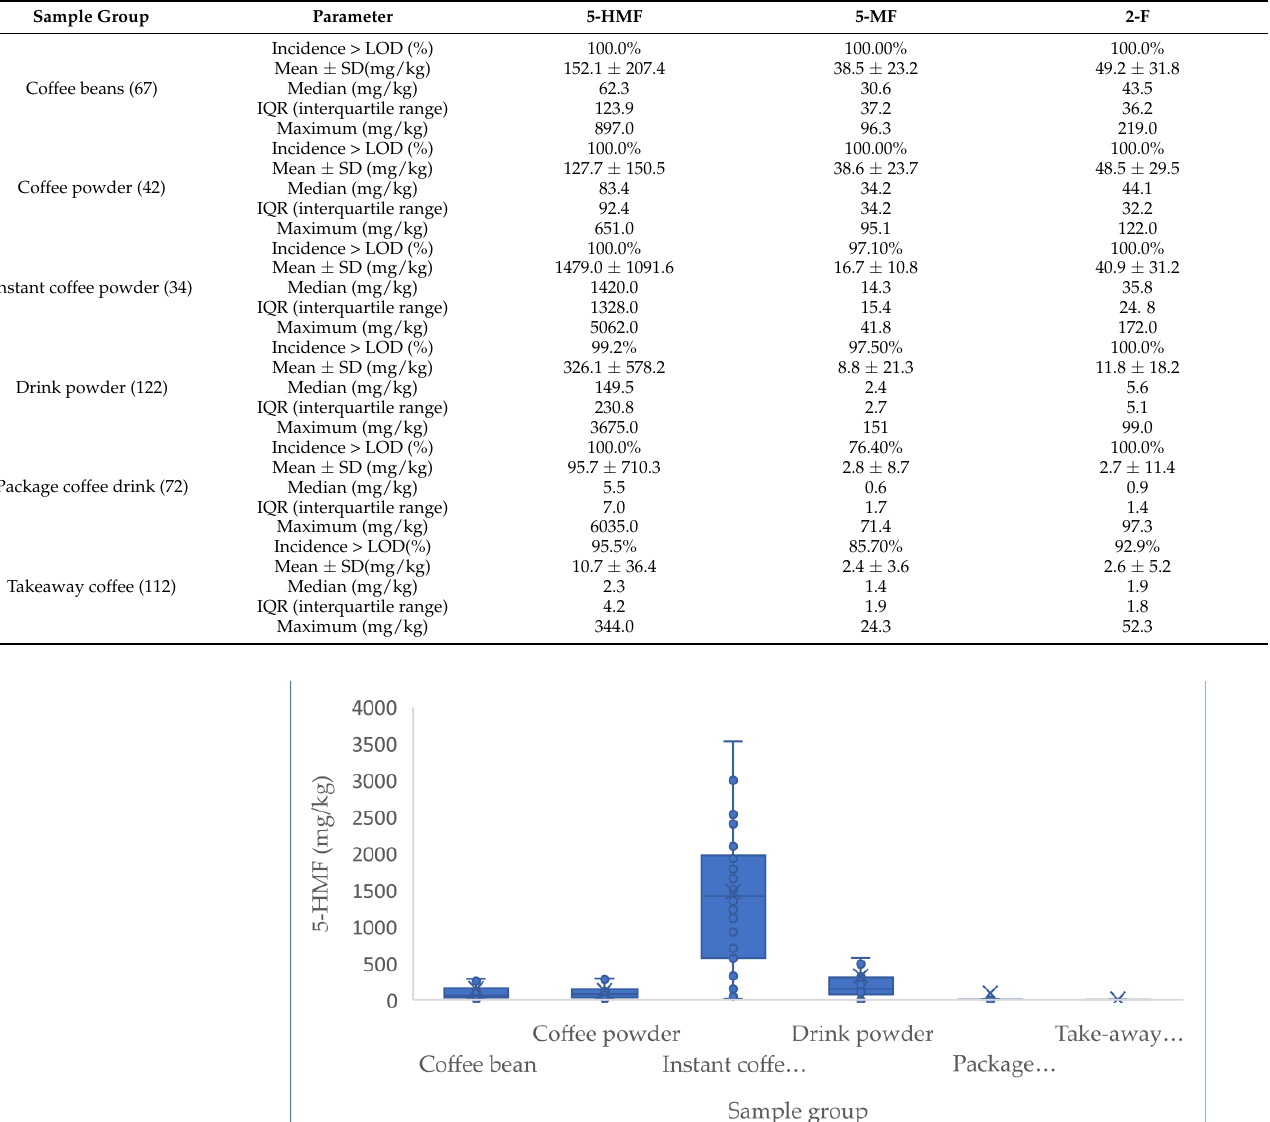
Table 3. Occurrence and contamination levels of furfural and its derivatives in coffee products of China in 2021.